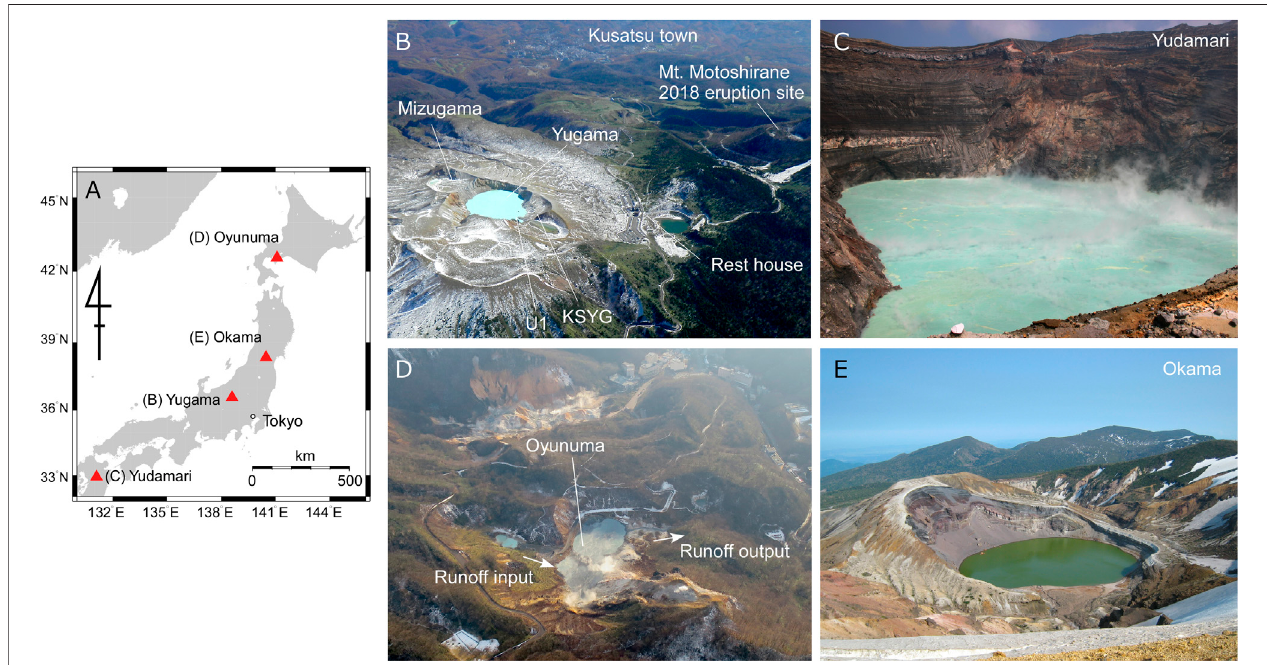
FIGURE1 |(A) Locationmap of active crater lakesin Japan. Photographsof (B) Yugama crater lakeat Kusatsu – Shiranevolcano taken on November 6,2017, (C) YudamaricraterlakeatAsovolcanotakenbyShinYoshikawaonJuly27,2007, (D) OyunumacraterlakeatNoboribetsuvolcanotakenbyHiroshiAoyamaonDecember 7, 2020 with the cooperation of the Hokkaido Regional Development Bureau, and (E) Okama crater lake at Zao volcano taken by Mare Yamamoto on May 29, 2017.